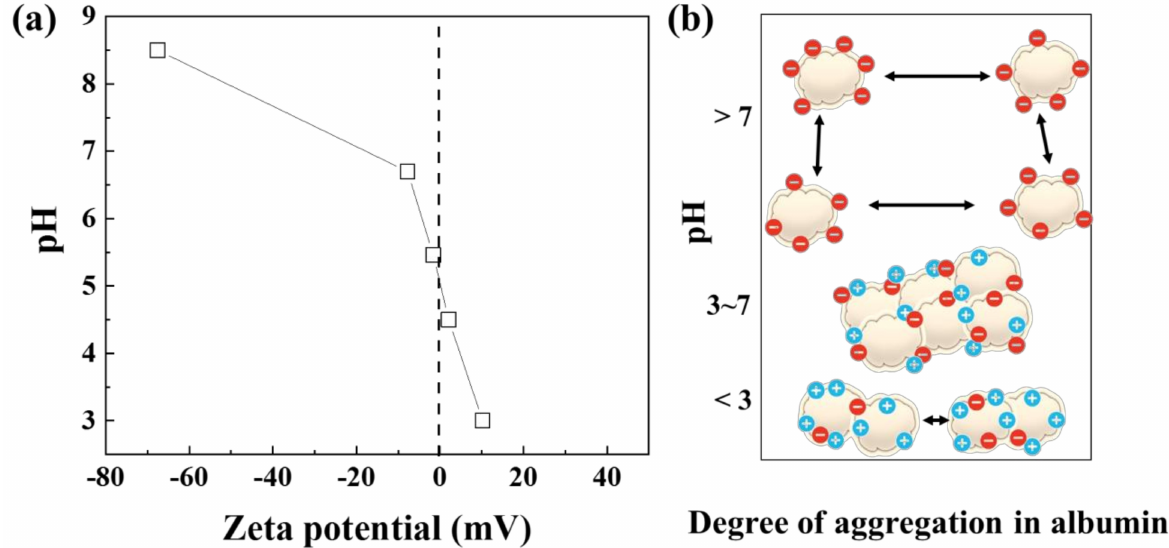
Figure 1. ( a ) Effect of pH on zeta potential of albumin and ( b ) schematic diagram describing the degree of aggregation depending on